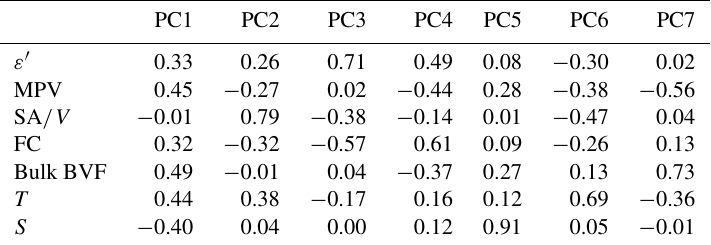
Table 3. Results from principal component analysis for ε (cid:48) at 10Hz and loadings associated with each variable. Mean pore volume (MPV), surface area to volume ratio (SA /V ), depth of 25% fractional connectivity (FC), bulk brine volume fraction (bulk BVF), sample